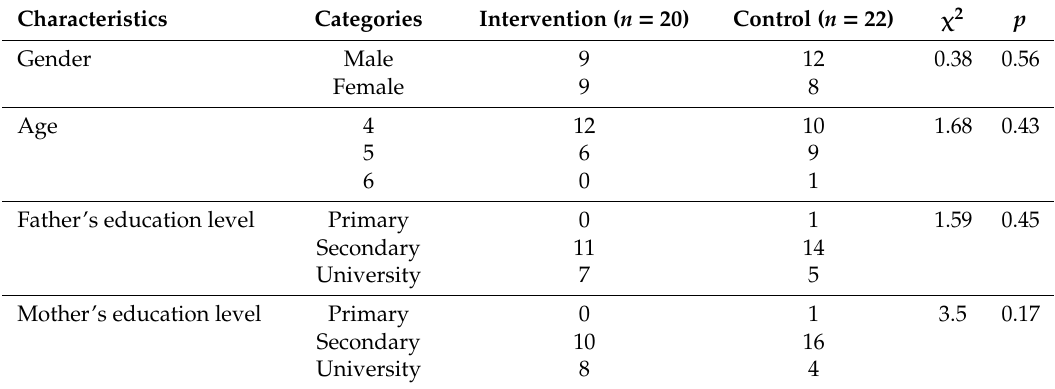
Table 1. Socio-demographic characteristics of the young children and their parents ( n = 42). Characteristics